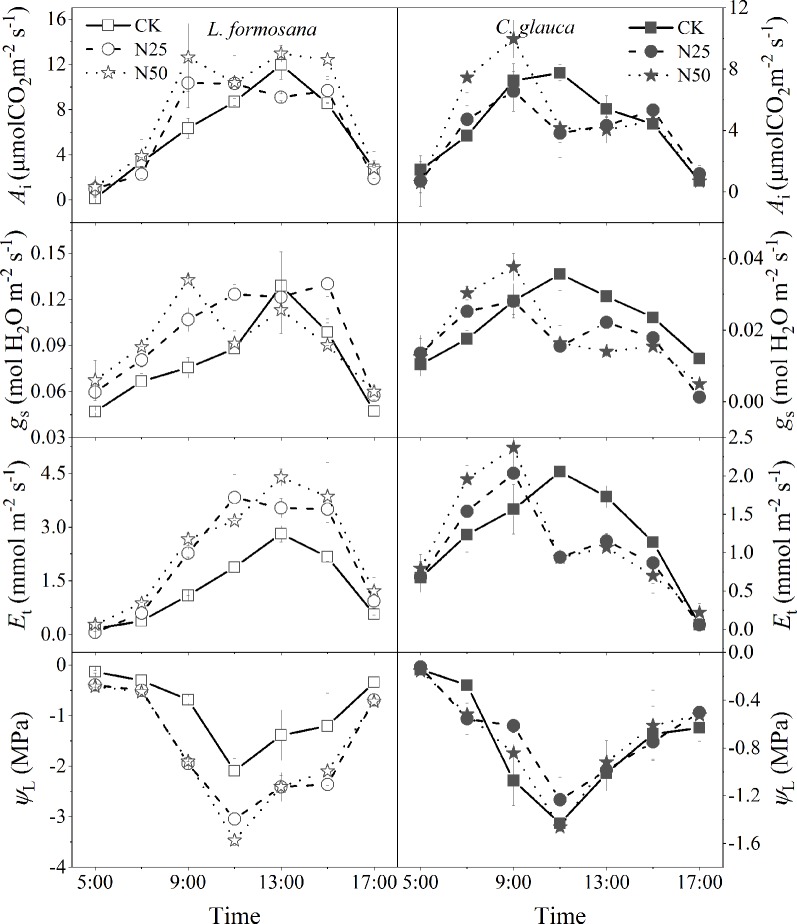
Daily dynamics of leaf instantaneous net photosynthetic rates (A
i), stomatal conductance (g
s), transpiration rates (E
t), and water potential (Ψ
L) across the three N treatments for Liquidambar formosana and Cyclobalanopsis glauca, respectively. Error bars correspond to the ± standard error of three individuals in each group.